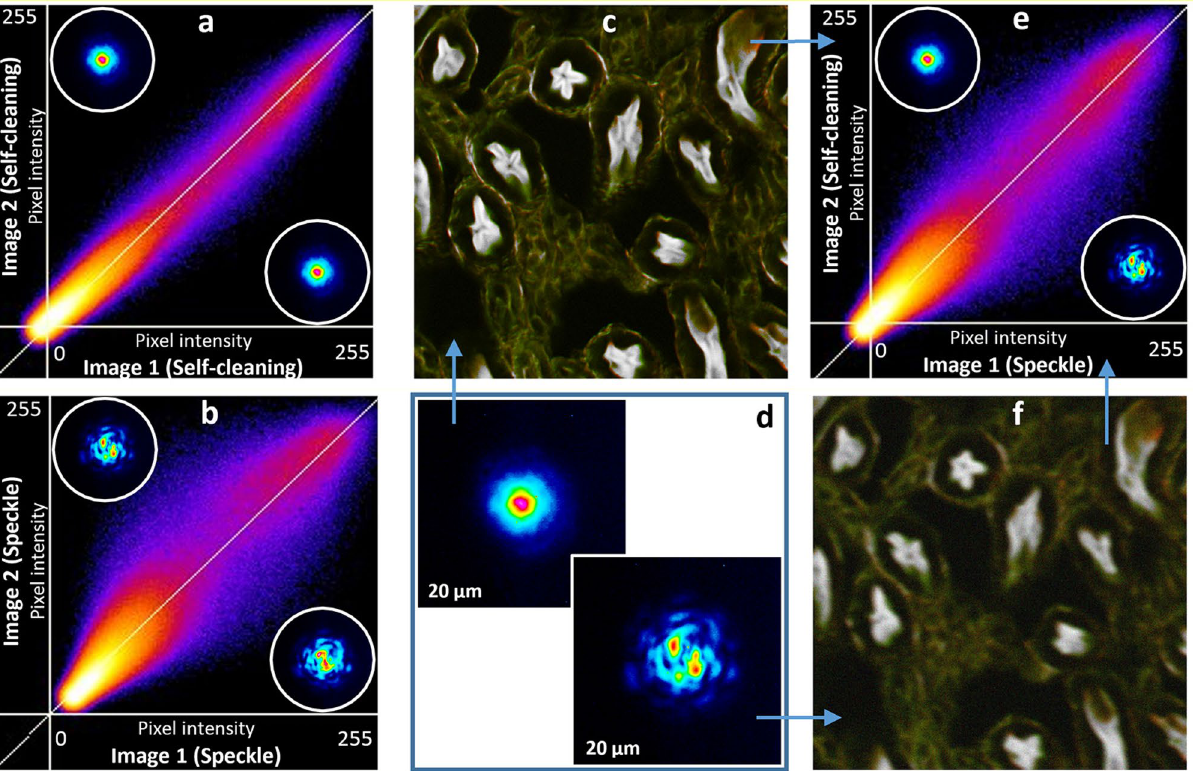
Figure 3. Illustration of self-cleaning robustness, resulting to the image stability. Intensity correlation (ImageJ technics- correlation of the pixel intensities) of colocalizing objects is used. Continuous squeezing is applied to the multimode fiber for ( a ) and ( b ). ( a ) Intensity correlation between two different images, recorded with the self-cleaned output beam at 1064 nm. ( b ) Same for the speckled output beam. ( d ) and insets: 2D images of the output beams with (Left) and without (Right) spatial self-cleaning. ( e ) Comparison between images recorded with a speckled and a self-cleaned beam. ( c ) Example of images, used for intensity correlation, taken with a self- cleaned output beam. ( f ) Exactly the same zone, with the speckled output